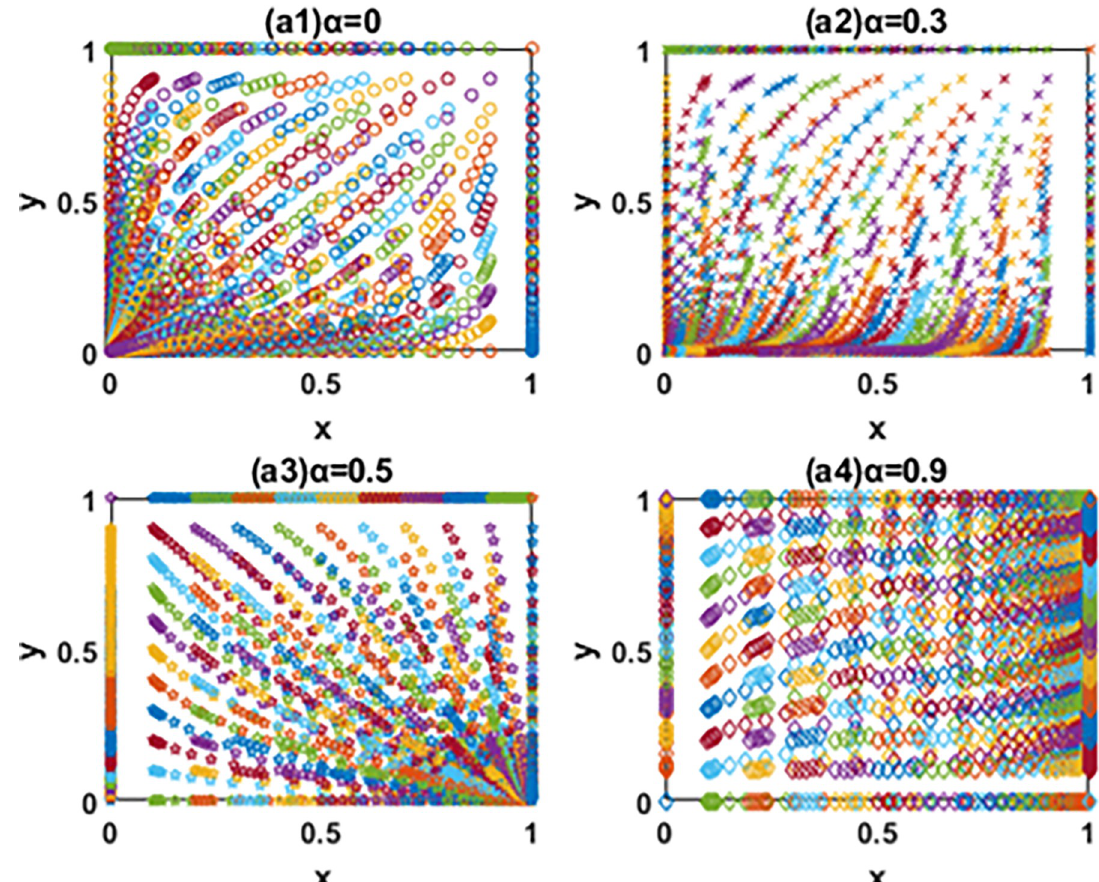
Fig 6. Effects of α on the path selection of